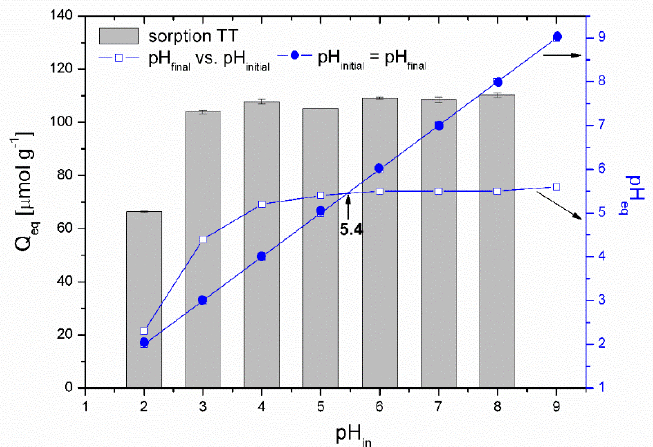
Figure 9. pH pzc determination and the effect of initial pH on the adsorption of TT (313 μ mol L − 1 ) by the magnetically responsive biosorbent (2.5 g L − 1 ; T = 22 °C).